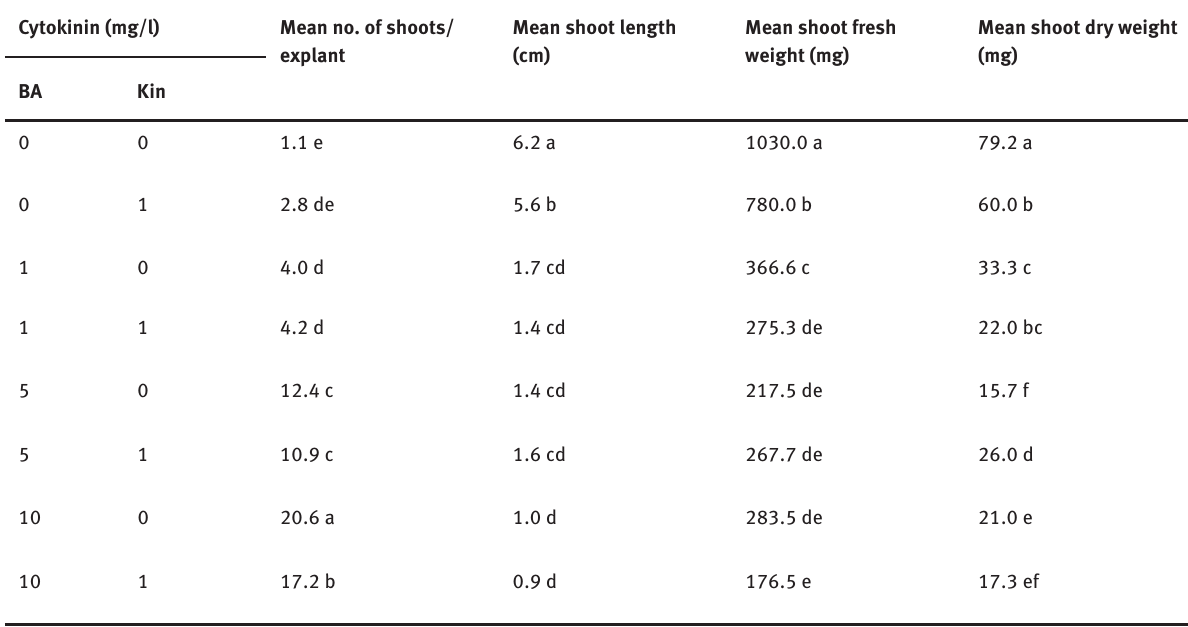
Table 1: Effect of BA and Kin on shoot multiplication of ginger.